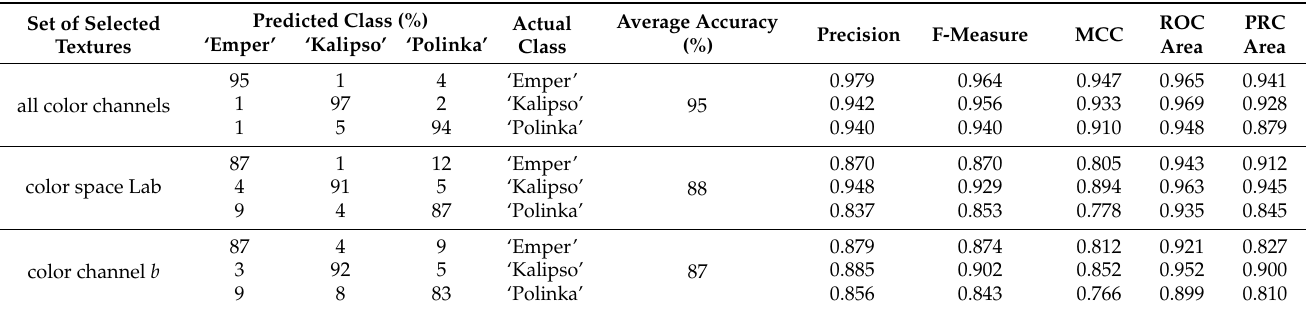
Table 2. The results of cultivar discrimination of plum kernels performed using models built based on textures selected from all color channels L , a , b , R , G , B , U , V , S , X , Y , Z , color space Lab, and color channel b using the PART (Rules) classifier.